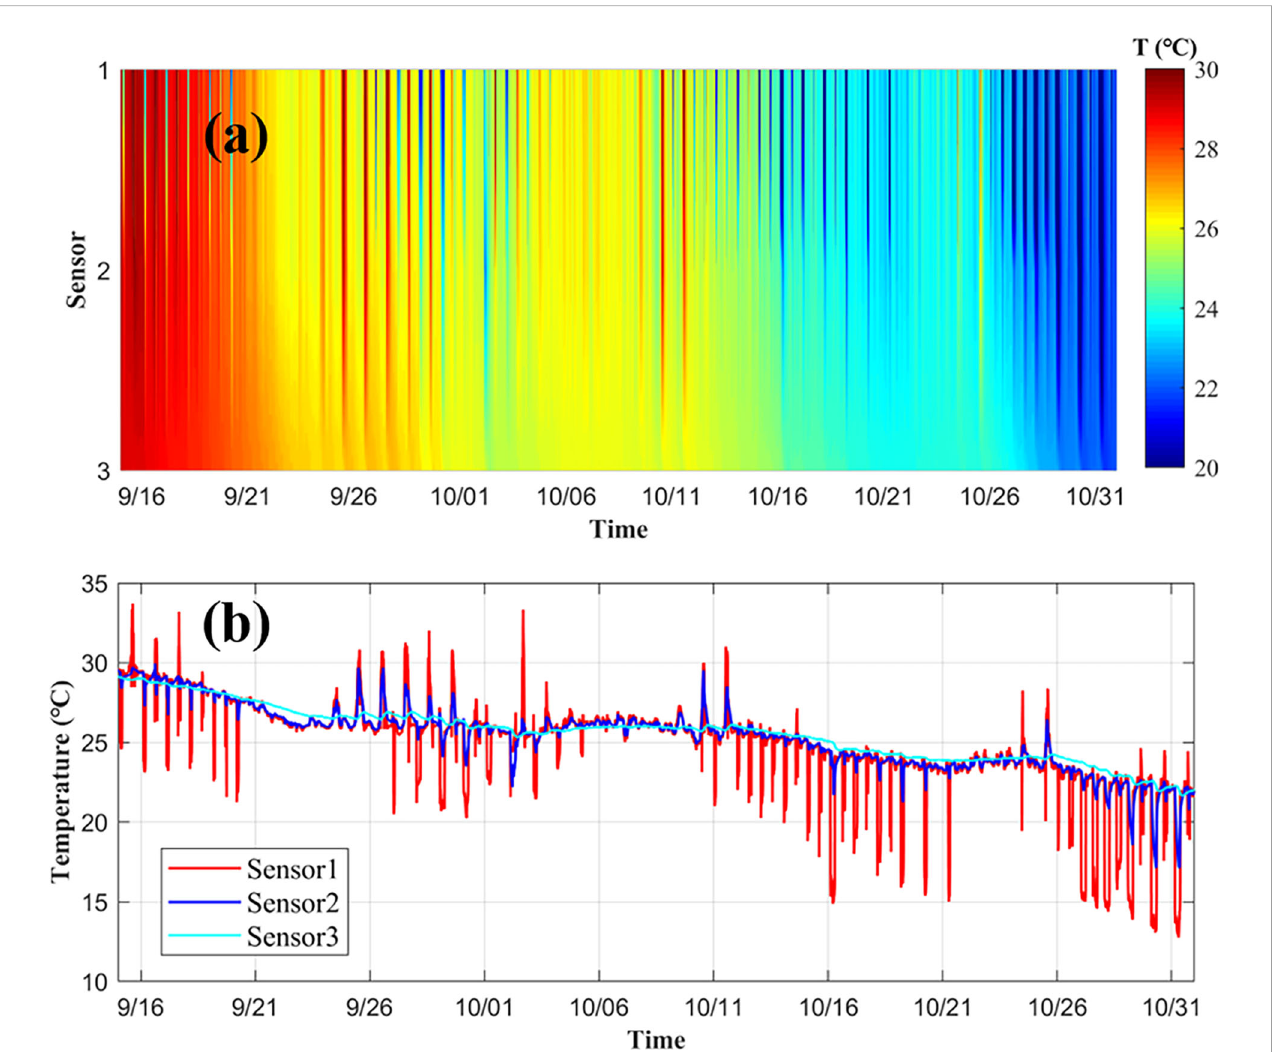
FIGURE 8 Time series of temperature near station S2 in the tidal fl at: (A) color contours and (B) time series. Sensor 1, 2, and 3 in the legend indicate the sensor at the seabed surface and 20 cm and 82 cm inside the mud, respectively (from September 15 to October 31,